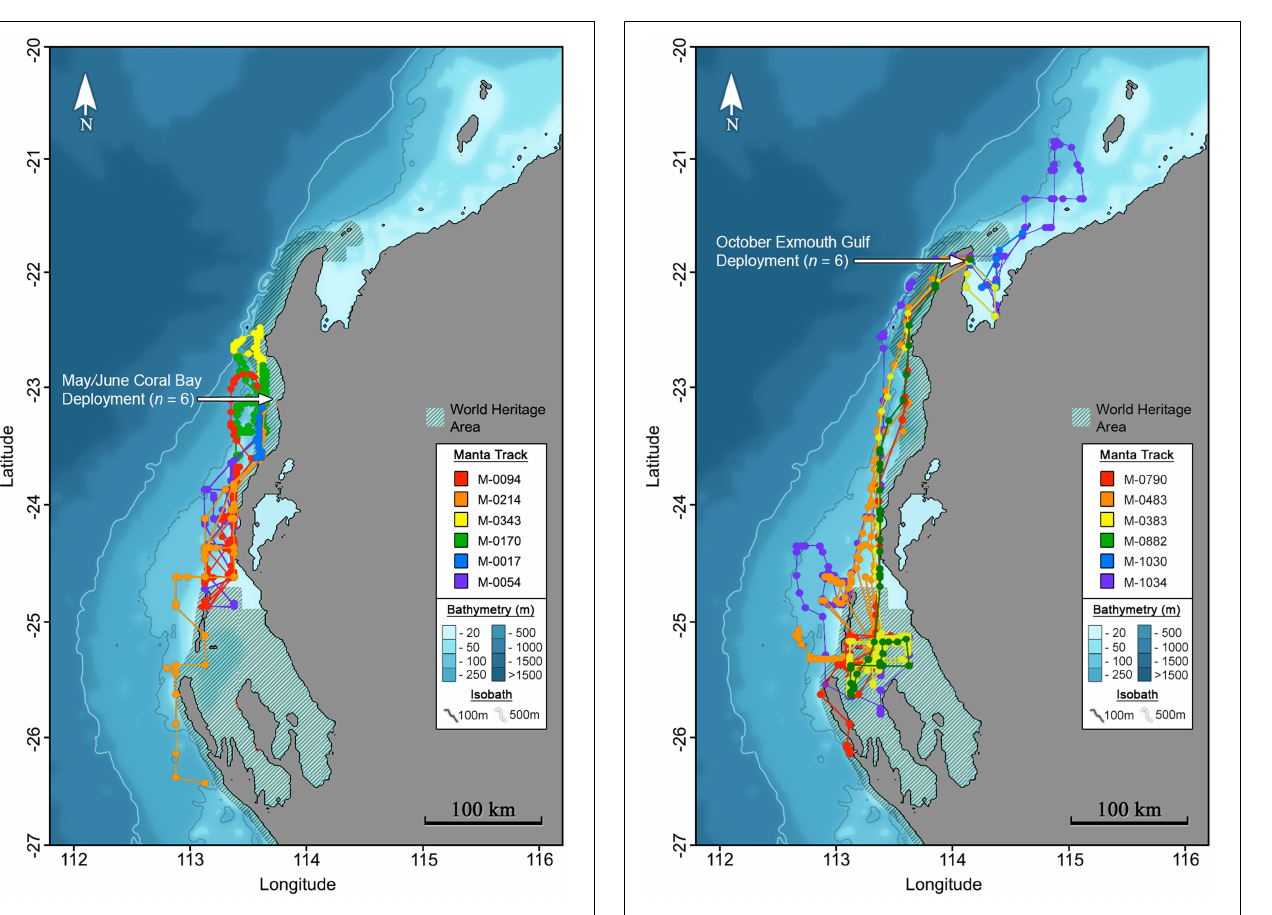
FIGURE 2 | Maximum likelihood tracks for M. alfredi ( n = 6) tagged in Coral Bay, Western Australia during May/June 2016. Track points represent 12-hourly maximum likelihood locations from light-based geolocation analysis implemented in the Wildlife Computers Global Position Estimator (v3), and consecutive observations are connected by the shortest straight-line distance.